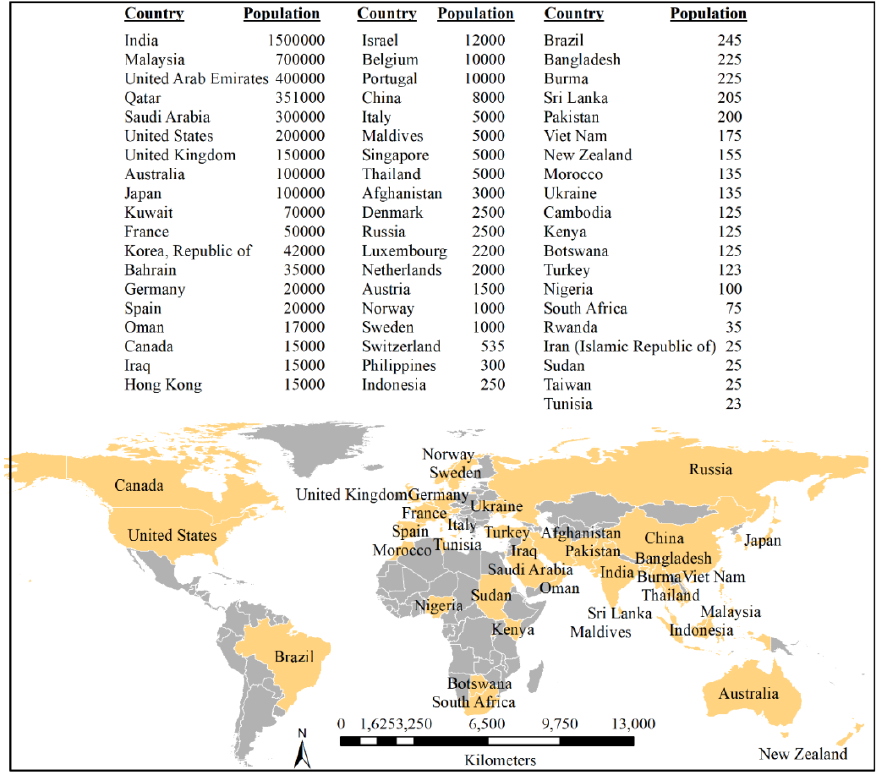
Figure 1. Nepali are working in foreign countries (yellow color) for remittance purposes. Remittances are one of the major contributors to the Nepali economy for education, health, poverty alleviation, financial institutions operation, and infrastructural development. Source: [1,2].